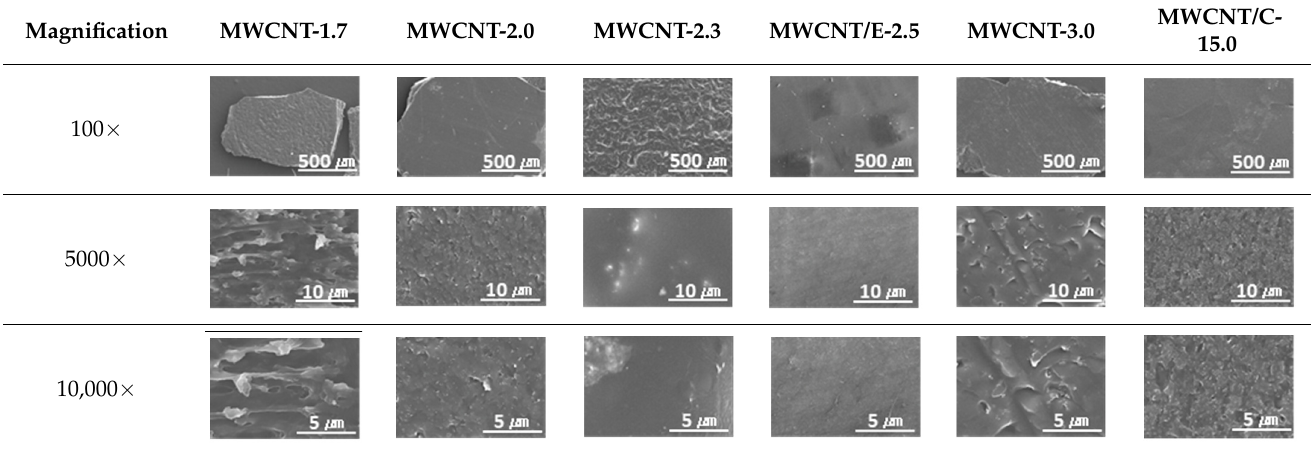
Table 3. Morphology of bush surfaces according to MWCNT content.